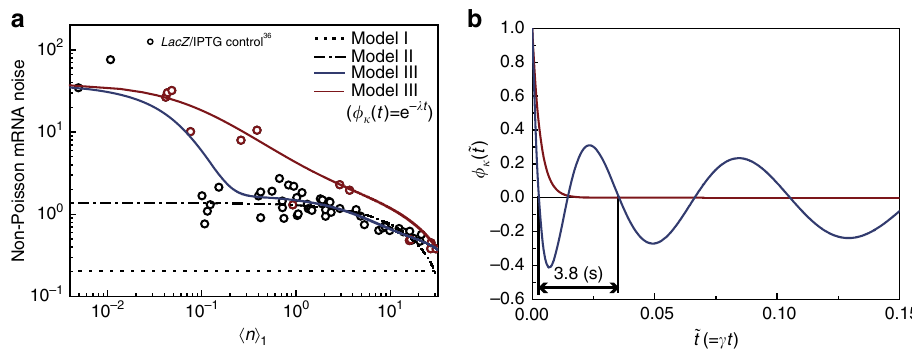
Fig. 2 Dynamics of transcription rate fl uctuation consistent with cell-to-cell variation in the number of mRNA expressed from repressor-regulated lacZ in E. per single-gene copy and non-Poisson mRNA noise Q n = n h i g h i Q n = n h ið Þ for various coli . a (circles) Experimental data for the mean mRNA number h n i 1 1 ¼ concentrations of inducer IPTG 36 . The decay rate, γ , of the lacZ mRNA is 1/120 Hz 36 . The red circles represent the data obtained from slowly growing cells with doubling times greater than 45 min. The experimental data were reported in Fig. 3 of ref. 36 . (dotted line) The result of Model I, for which Q n = n h i is 1 the same as the Fano factor ð F g ffi 0 : 21 Þ of the gene copy number variation (Supplementary Note 16). (dot-dash line) Result of Model II. Non-Poisson mRNA noise also emerges from the gene-state switching process. (blue solid line) Result of Model III. The fl uctuation in transcription rate κ produces additional mRNA noise. By comparing Model III and the entire data, we extract the time pro fi le of the TCF, ϕ κ ð t Þ , of transcription rate κ . (red line) Result of Model III with ϕ κ ð t Þ modeled as exp ð(cid:2) λ t Þ , which is in good agreement with only the red circle data. The optimized value of λ = γ is 306. The major contributors to non-Poisson mRNA noise are those from the gene-state switching process and its bilinear coupling with the ensuing transcription process, corresponding to the last two terms on the R.H.S. of Eq. (2) (Supplementary Note 17 and Supplementary Fig. 16a). b (blue line) ϕ κ ð t Þ extracted from the entire data shown in a using Model III. (red line) Exponential TCF, ϕ κ ð t Þ ¼ e (cid:2) λ t , extracted from the red circle data in a , obtained from the slowly growing cells. The dependence of the non-Poisson mRNA noise on the mean mRNA level is consistent with the known mechanism of IPTG-regulated